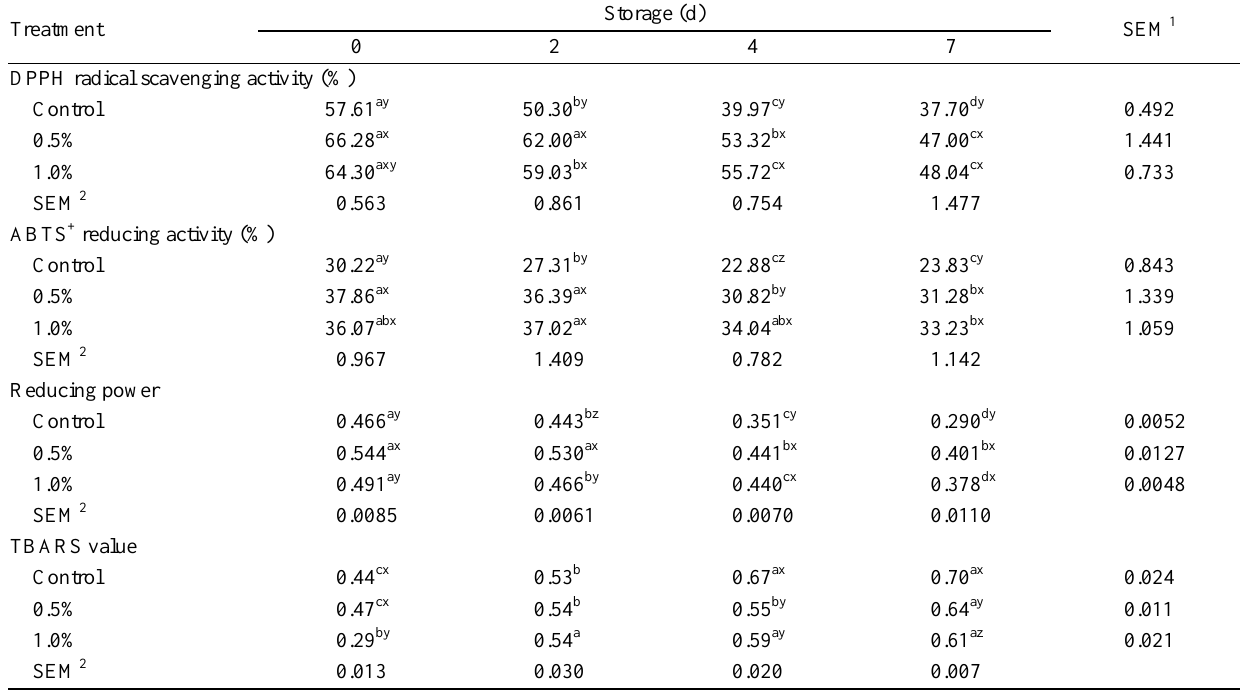
Table 2. Antioxidative activities of the thigh meat from the broilers fed the combination of gallic and linoleic acid during storage at 4  C